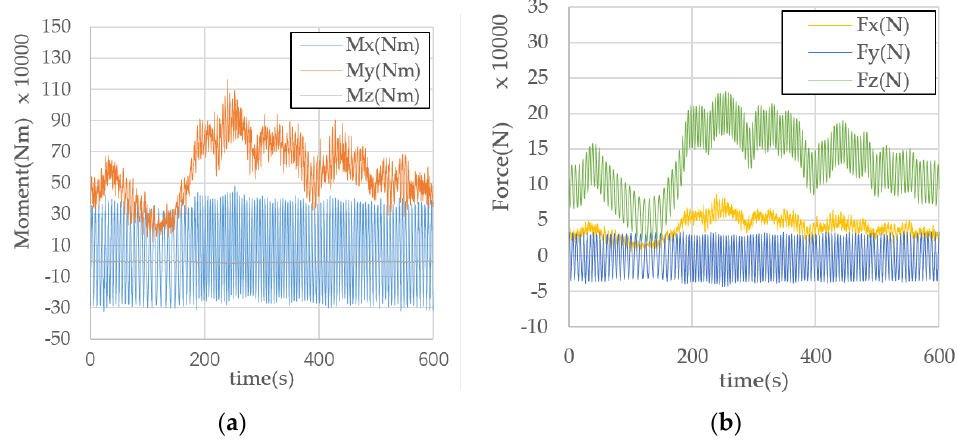
Figure 11. Loads of the section with relative thickness of 33% under one normal generating condition: ( a ) Moments; ( b ) Forces.